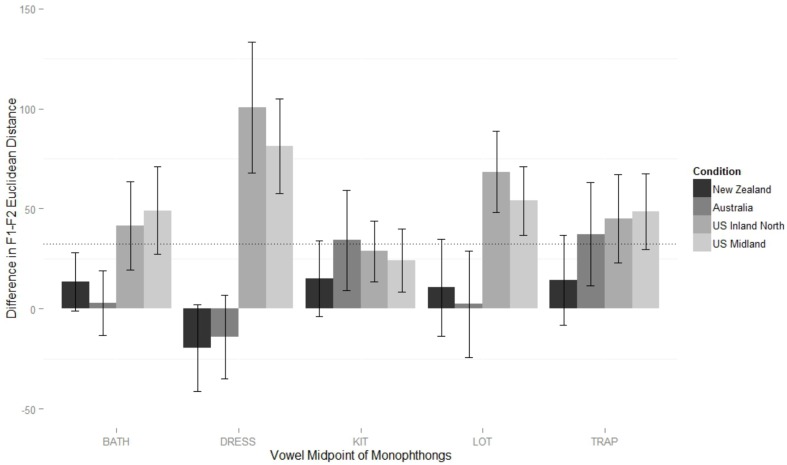
New Zealander participants' difference in Euclidean distance from models on monophthongs, from baseline reading to shadowed reading. Values at zero represent no shift, positive values a shift toward the model, and negative values a shift away from the model, compared to the baseline. Measurements are at the vowel 50% point. Error bars mark 95% confidence intervals. Dotted line represents grand mean of the linear regression model.